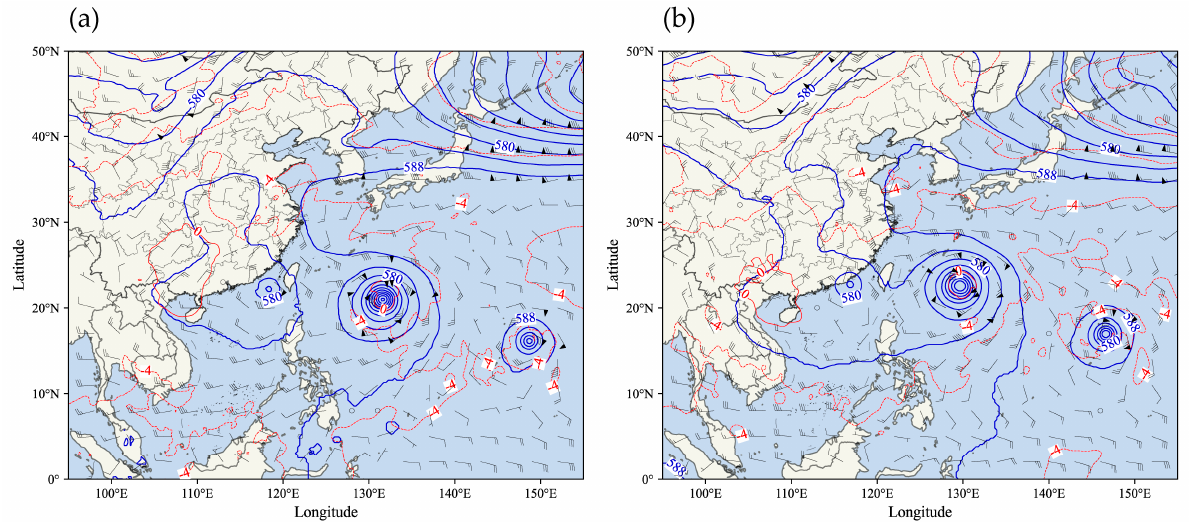
Figure 4. 500 hPa geopotential height (solid blue line, unit: dagpm), wind field (wind bar, long line = 4 m s − 1 , short line = 2 m s − 1 , wind triangle = 20 m s − 1 ) and isotherm (red line, unit: °C) at ( a ) 1200 UTC on 8 July and ( b ) 0000 UTC on 9 July 2015.